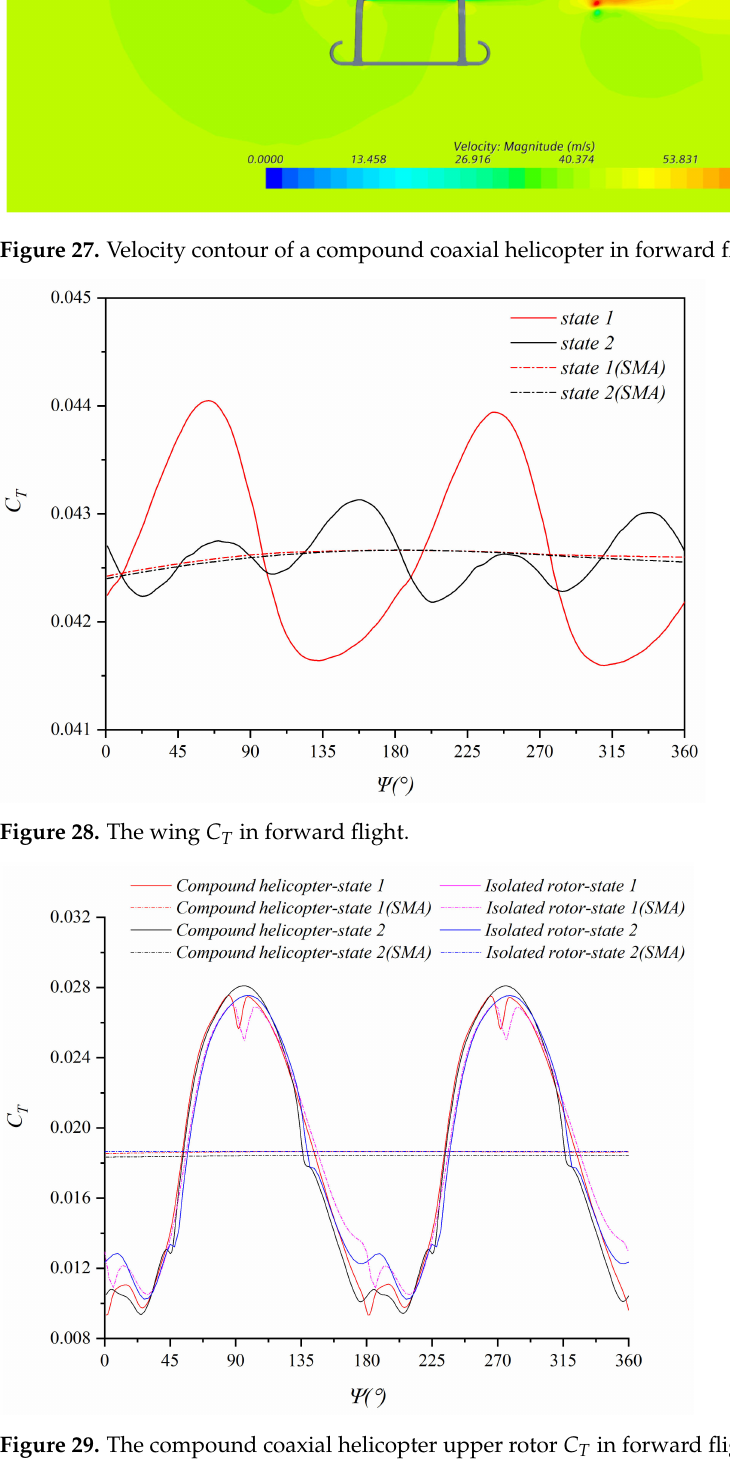
Figure 29. The compound coaxial helicopter upper rotor C T in forward